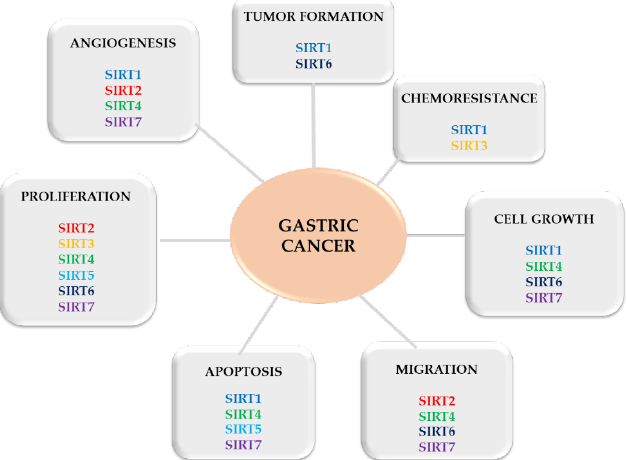
Figure 2. Progression of gastric cancer controlled by SIRTs. Table 1. The role of sirtuins in gastric cancer.